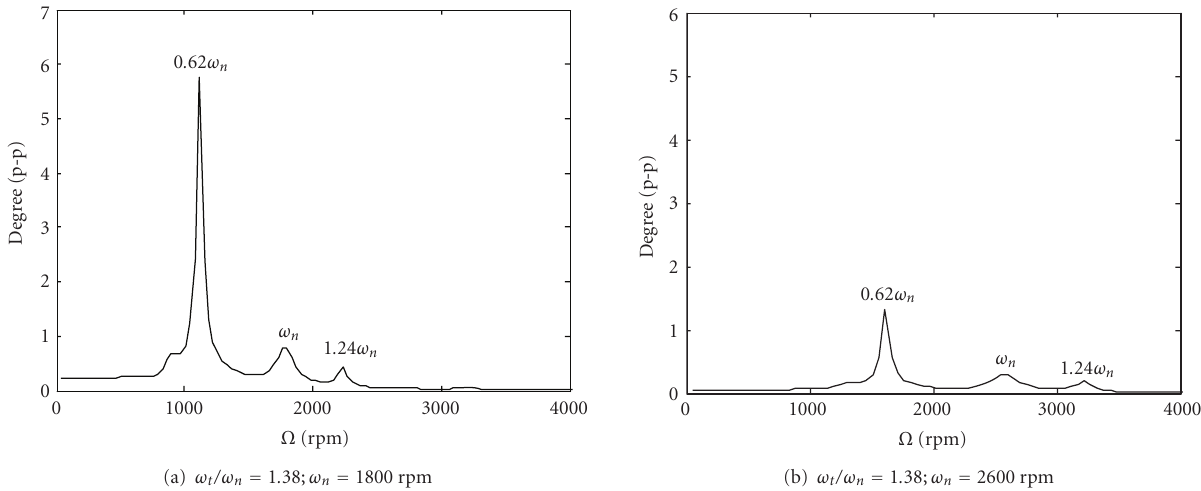
Figure 7: Overall peak-to-peak torsional vibration response, ϕ , general case, for asymmetric shafts with di ff erent lateral sti ff ness but constant torsional-to-lateral natural frequency ratio.